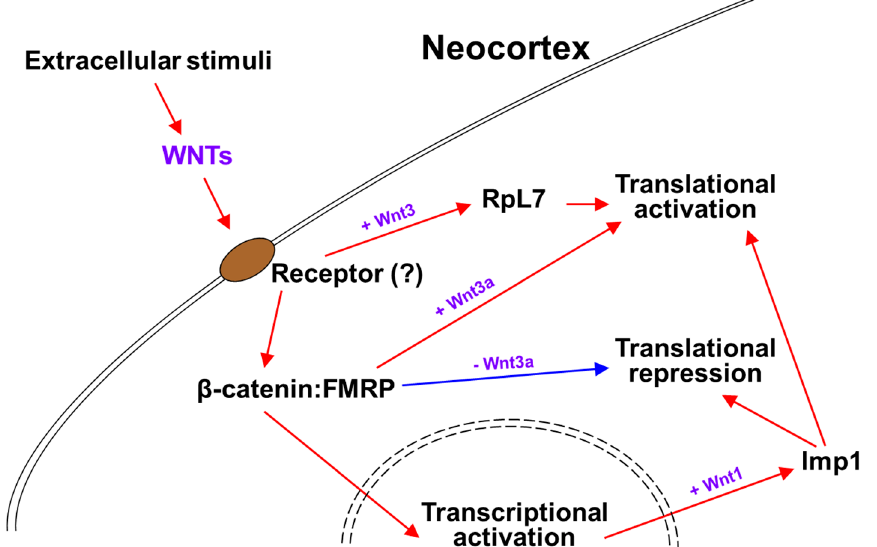
Figure 1. mRNA translations regulated by WNTs signaling. (1) Wnt3, secreted from thalamocortical axons, increases Rpl7 ribosomal protein within polysomes and promotes Foxp2 mRNA translation in the neocortex [48]. (2) Wnt3a stimulation induces the translational activation of mRNAs by sequestering β -catenin away (red arrow) from the β -catenin and FMRP complex that sustains the translational repression state (blue arrow) [97]. (3) Wnt1 signaling enhances RBP Imp1 expression during cortical development, which both translationally silences proneurogenic mRNAs and in- creases expression of pro-self-renewal mRNAs, to maintain NSCs in an undifferentiated state [98].